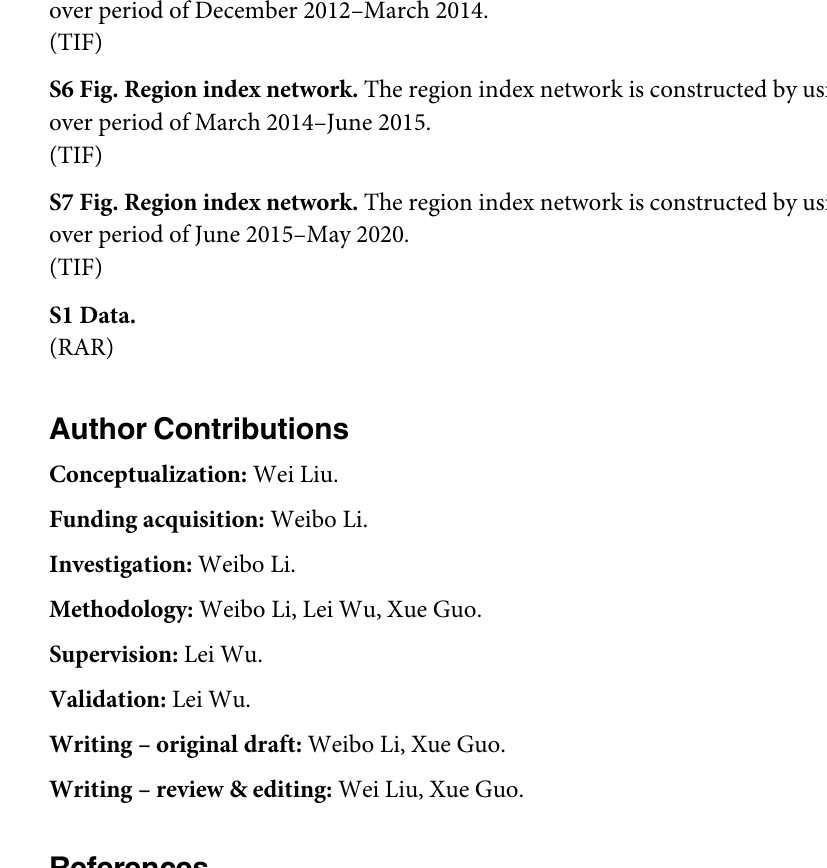
S5 Fig. Region index network. The region index network is constructed by using PMIME over period of December 2012–March 2014. (TIF) S6 Fig. Region index network. The region index network is constructed by using PMIME over period of March 2014–June 2015. (TIF) S7 Fig. Region index network. The region index network is constructed by using PMIME over period of June 2015–May 2020. (TIF) S1 Data.